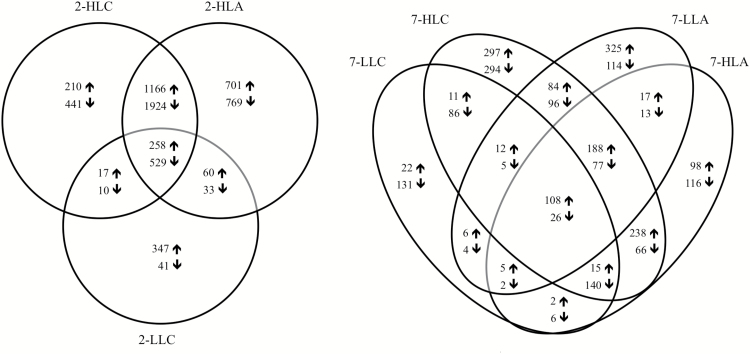
Venn diagram of differentially up-regulated (upward arrow) and down-regulated (downward arrow) transcripts in Desmarestia anceps after exposure to the different experimental conditions in comparison to the control (2-LLA). The number of regulated transcripts shared by the intersected treatments is shown for each intersection.